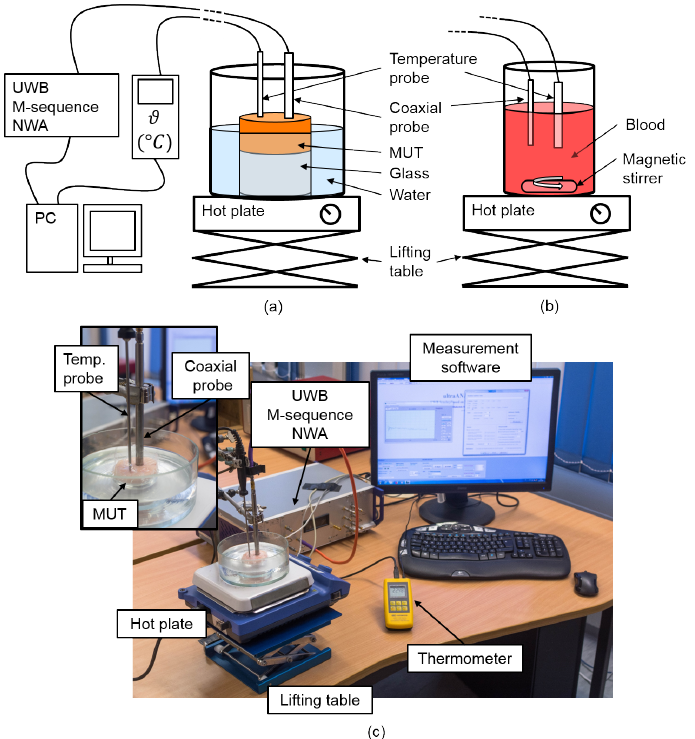
Figure 2. Measurement setup for temperature dependent ultra-wideband (UWB) spectroscopy of ( a ) tissue and ( b ) blood using an UWB M-sequence network analyzer (NWA) connected to a